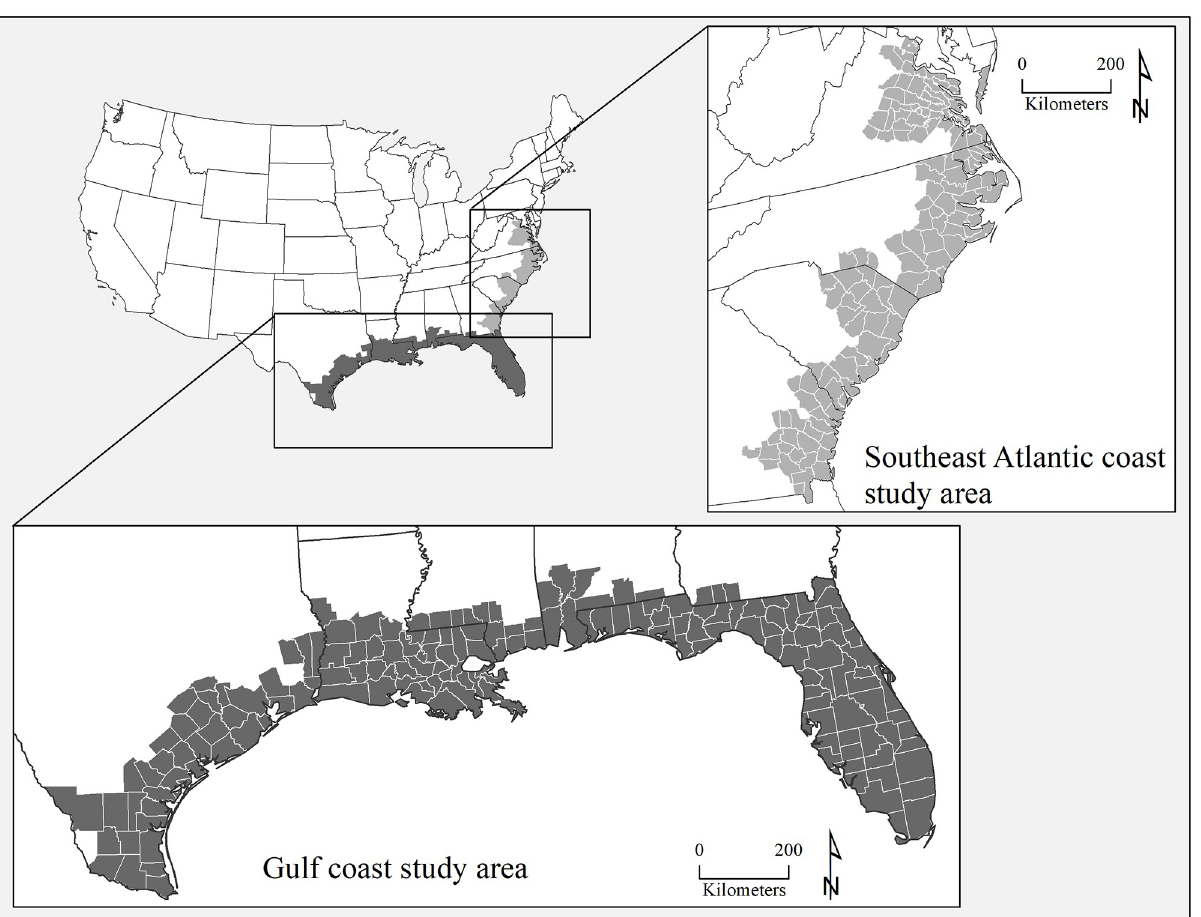
Fig 3. Study regions of Gulf Coast, and southeast Atlantic coast. County and state boundaries are retrieved from the U.S. Census Bureau (https:// www.census.gov/geographies/mapping-files/time-series/geo/carto-boundary-file.html).